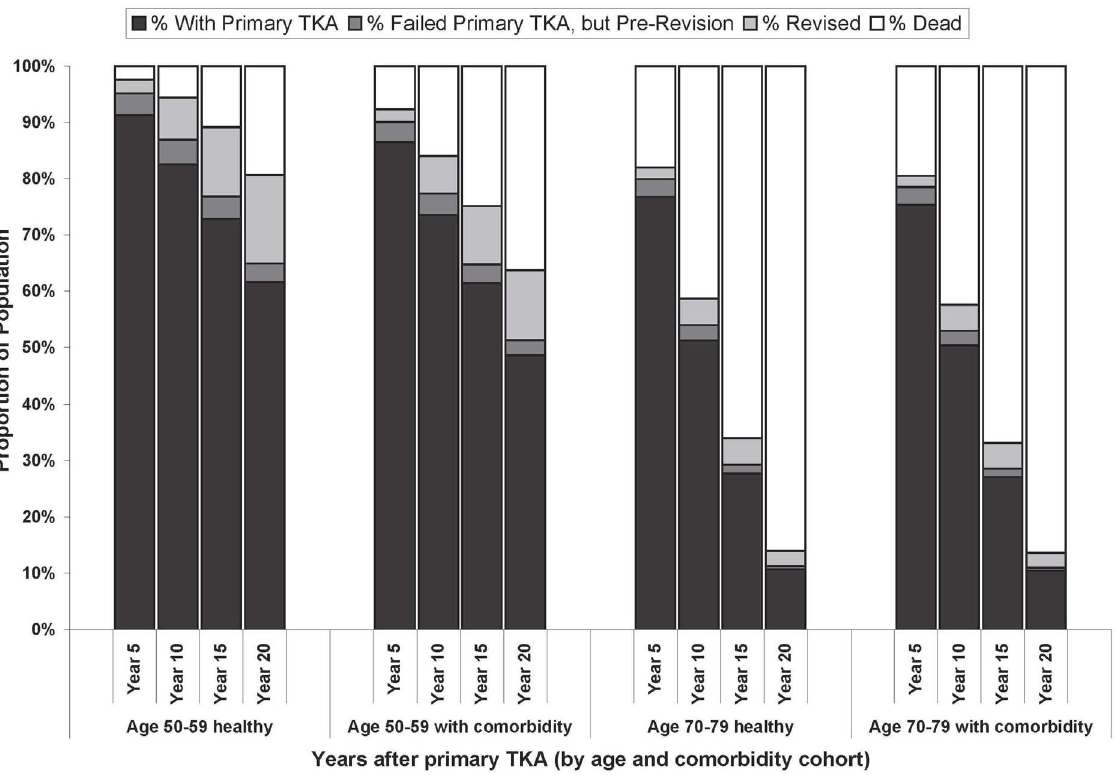
Figure 1. Proportion of population alive with original implant after Standard TKA by age and comorbidity. The estimated proportion of the population surviving with a successful primary TKA implant are noted by black bars among each of the four cohorts at 5, 10, 15, and 20 years after standard TKA. The dark grey bars represent the proportion of the population who have experienced technical TKA failure but have not undergone revision either due to the fact that their failure has not been observed by either the patient or their physician or they have been offered revision but refused. The light grey bars represent the proportion that has undergone revision TKA. As one moves from healthy 50–59-year-olds on the left to those with baseline comorbidity to healthy 70–79-year-olds and finally 70–79-year-olds with comorbidity on the far right, fewer individuals survive to experience TKA failure and therefore TKA revision. TKA=Total knee arthroplasty.